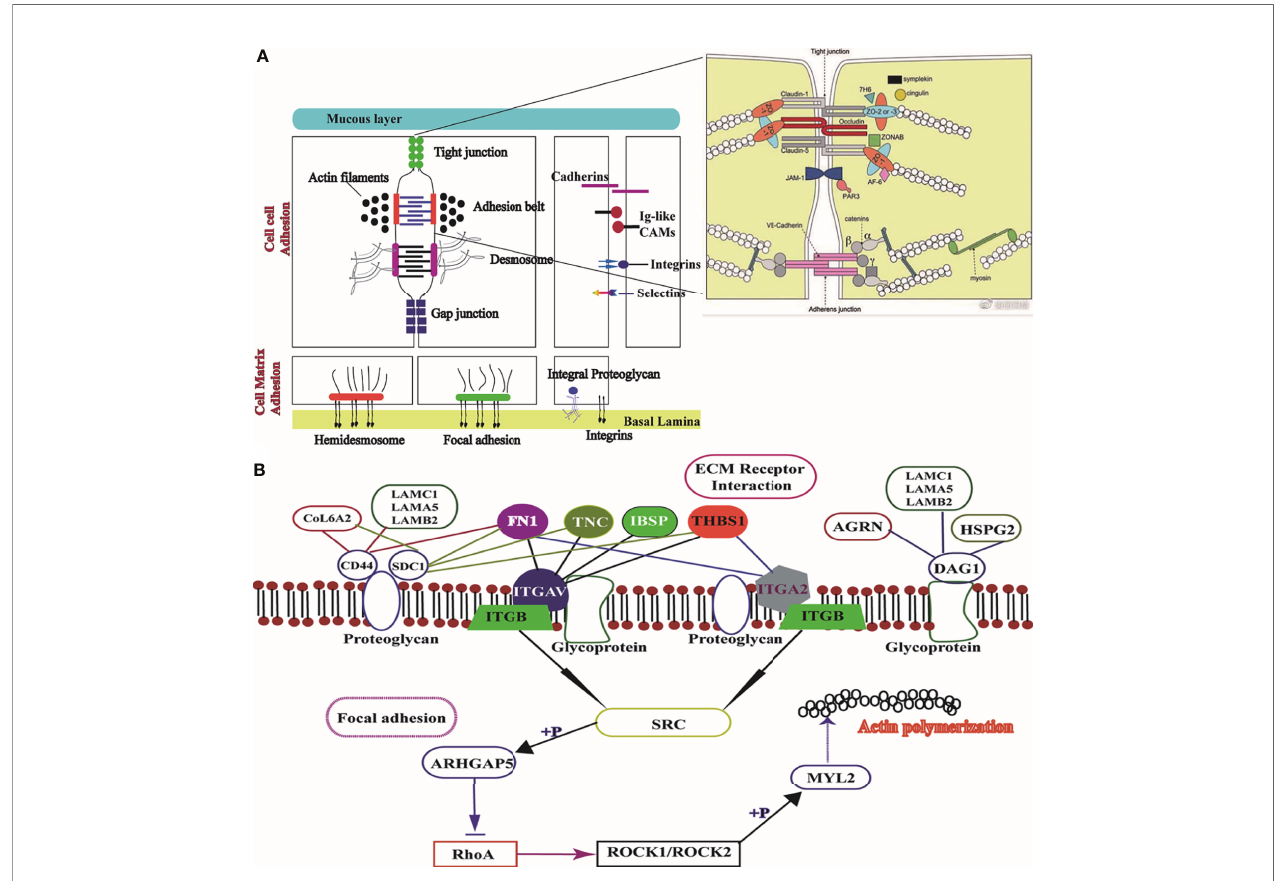
FIGURE 6 | Image of ECM receptor interaction and the focal adhesion signaling pathway. (A), Structure of the mucus layer, cell-cell adhesion, and cell-matrix adhesion of intestinal epithelial cells; (B) , Interaction mechanism of the difference factor for ECM receptor interaction and the focal adhesion signaling